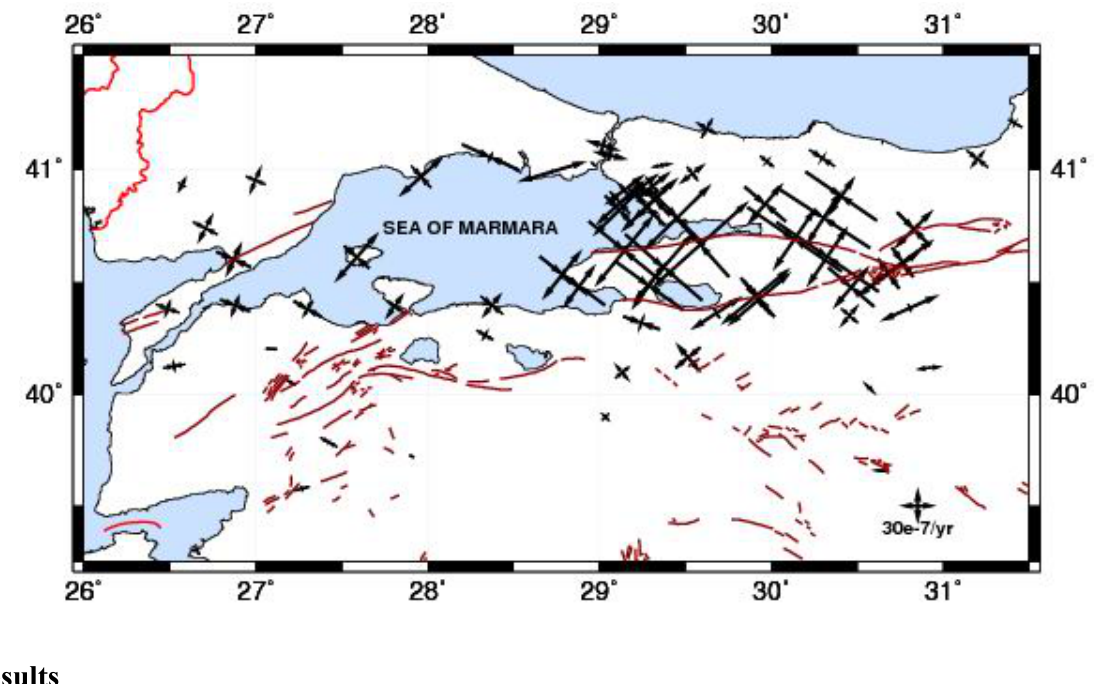
Figure 6. Principal strain rates ( ε velocities. Inside arrows indicate compression directions and outside arrows indicate extension directions.